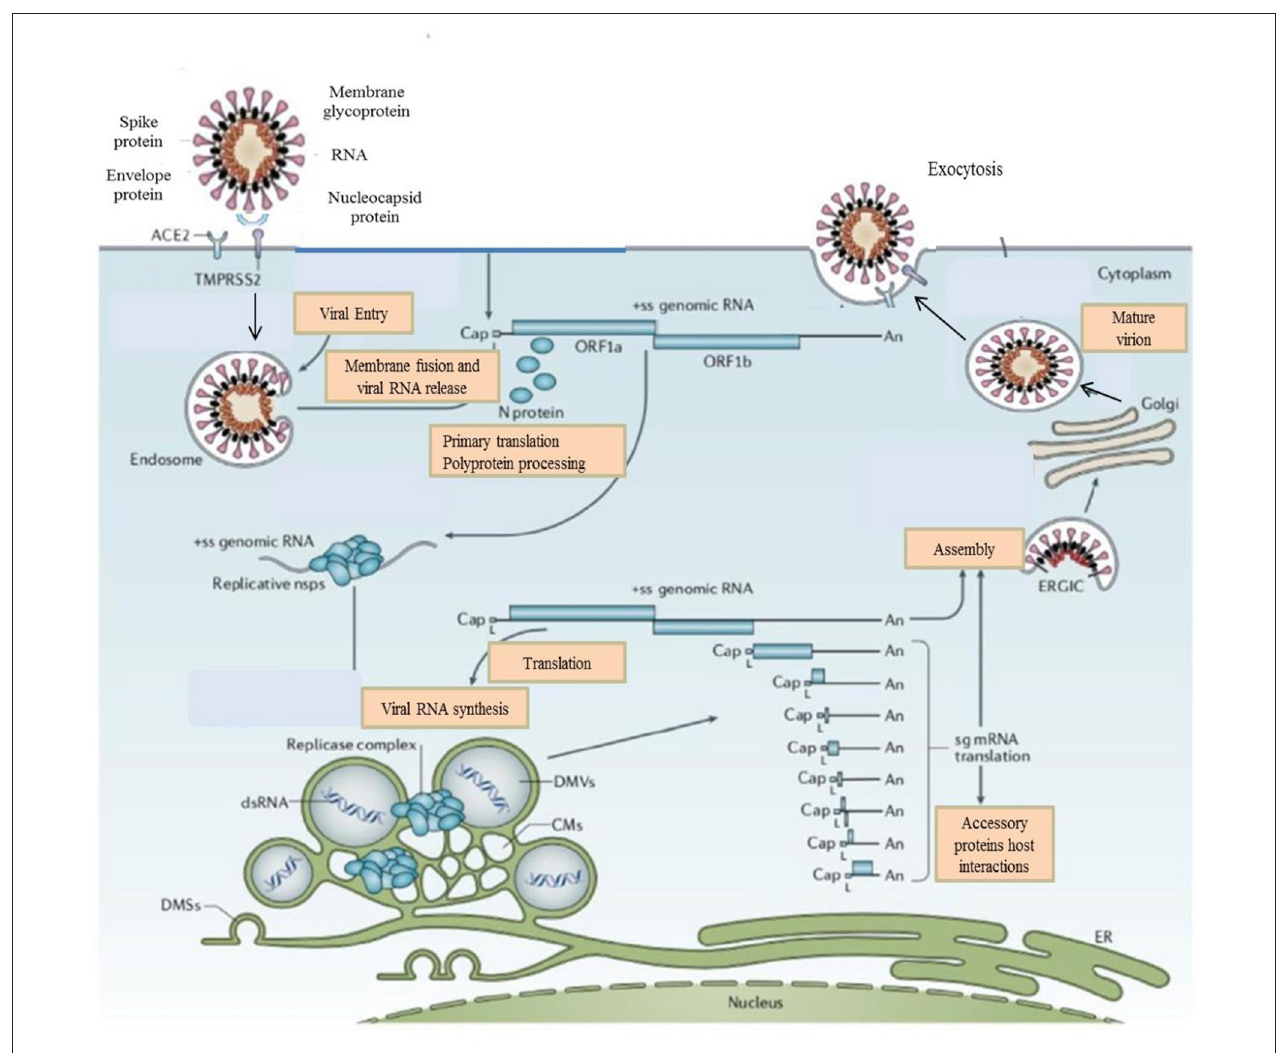
FIGURE 2 | Life Cycle of the Coronaviruses. Coronaviruses particles bind to ACE2 receptor. TMPRSS2 promote viral uptake and fusion at the cellular or endosomal membrane. Following entry, the release and uncoating of the genomic RNA subject it to the immediate translation of the two large open reading frames, ORF1a, and ORF1b. During the cellular life cycle, coronaviruses express and replicate their genomic RNA to produce full-length copies that are incorporated into newly produced viral particles